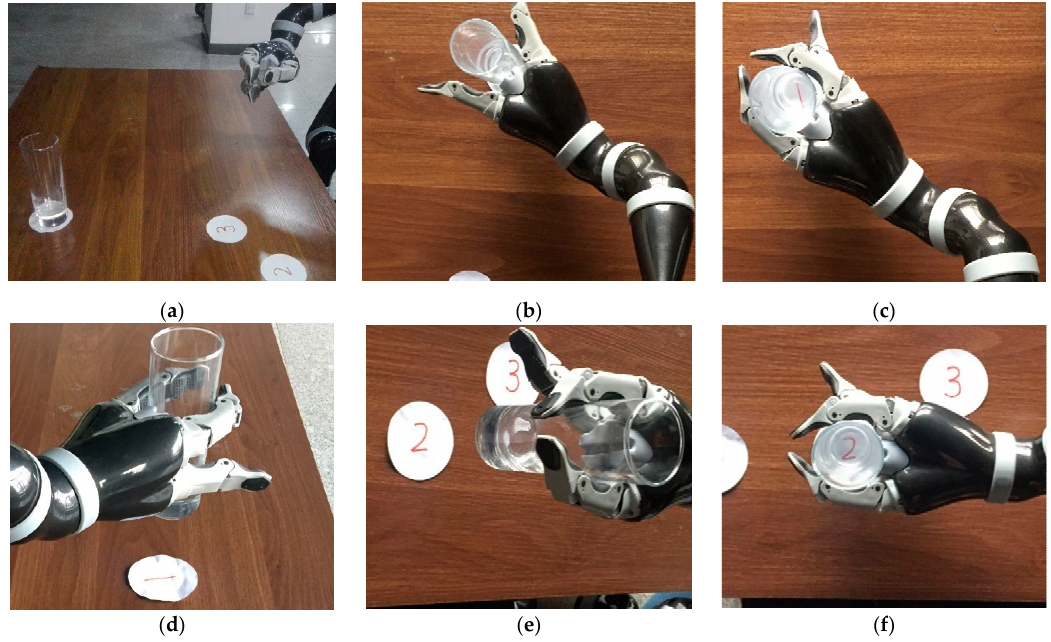
Figure 8. Demonstration process of placing a cup on the table: ( a ) home configuration; ( b ) reach the cup; ( c ) grasp the cup; ( d ) pick up the cup; ( e ) move to the goal position; ( f ) put down the cup.